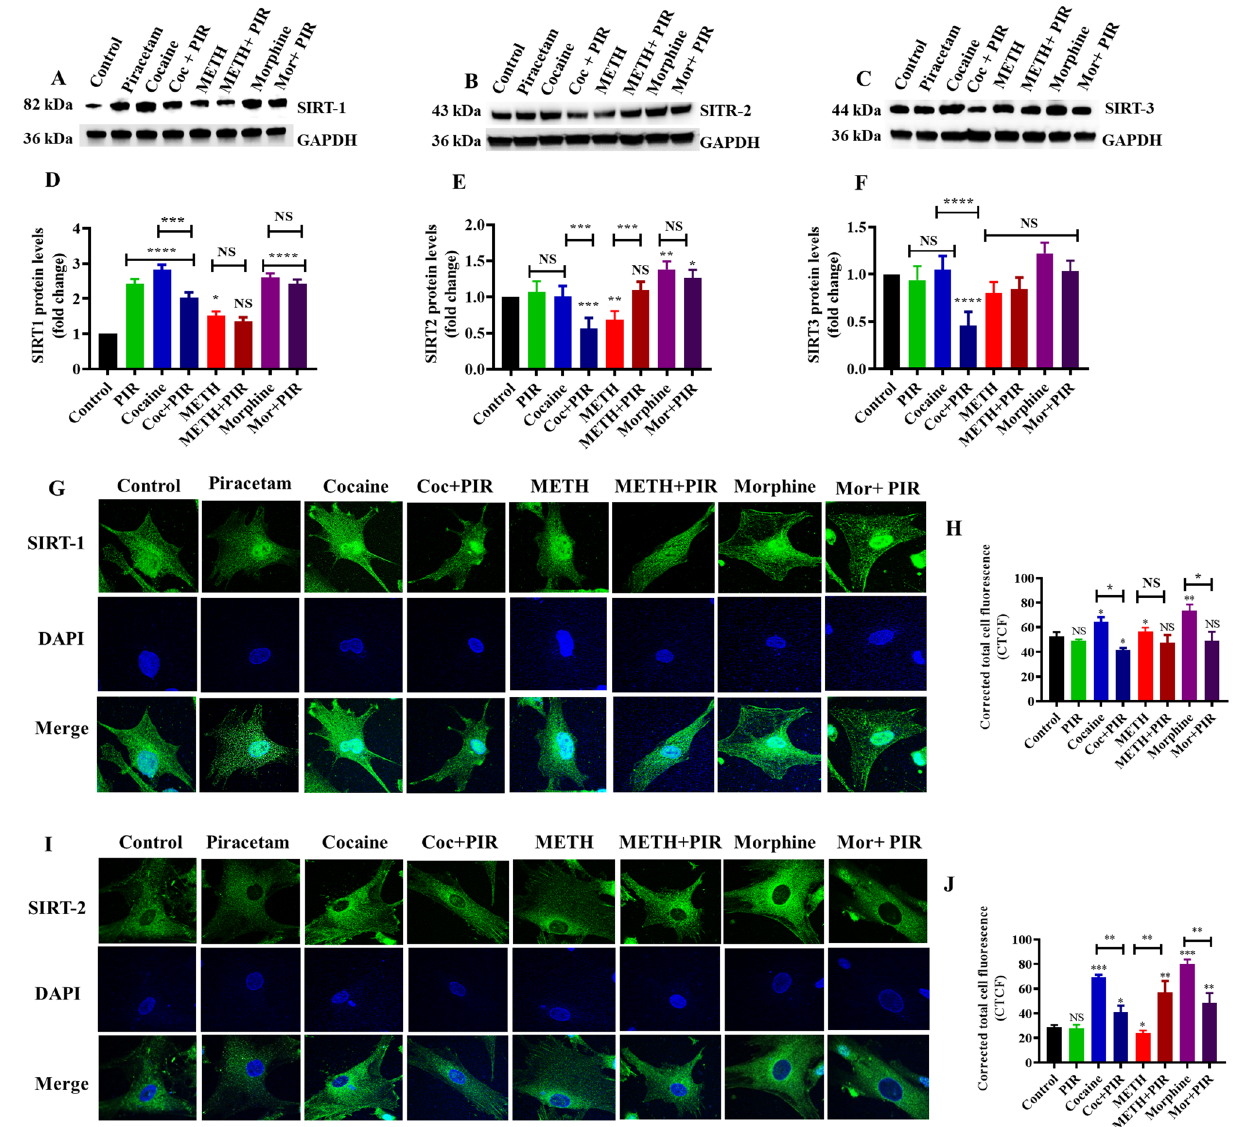
Figure 4. The protective effect of piracetam against the effects of psychostimulants and opioids on class I SIRT proteins. Human primary astrocytes were exposed to cocaine (1 µM), METH (10 µM) and morphine (5 µM) alone or in combination with piracetam (10 µM) for 24 h. Controls were maintained in drug-free medium (without drug exposure). Representative blots showing the expression of class I sirtuins ( A ) SIRT-1, ( B ) SIRT-2, and ( C ) SIRT-3. ( D – F ) Densitometric analyses of each protein level to its corresponding GAPDH loading control (fold-change from control). ( G ) Effects of psychostimulants and opioids on the expression and translocation of SIRT-1 in the cytoplasm and nucleus. SIRT-1 expression (green) and nuclear staining with DAPI (blue) were observed using confocal microscopy (magnification 100 × , scale bar 100 μm). ( H ) Quantification of SIRT-1 fluorescence intensity (CTCF). ( I ) Effect of psychostimulants and opioids on the expression pattern of SIRT-2 in the cytoplasm. SIRT-2 expression (green) and nuclear staining with DAPI (blue) were observed using confocal microscopy (magnification 100x, scale bar 100 μm). ( J ) Quantification of SIRT-2 fluorescence intensity (CTCF). Data are expressed as the means ± SD of three independent experiments. ***P < 0.001, **P < 0.01, *P < 0.05, NS—Nonsignificant. Coexposure of psychostimulant or opioid with piracetam compared to psychostimulant or opioid alone. The supplementary information includes all full-length